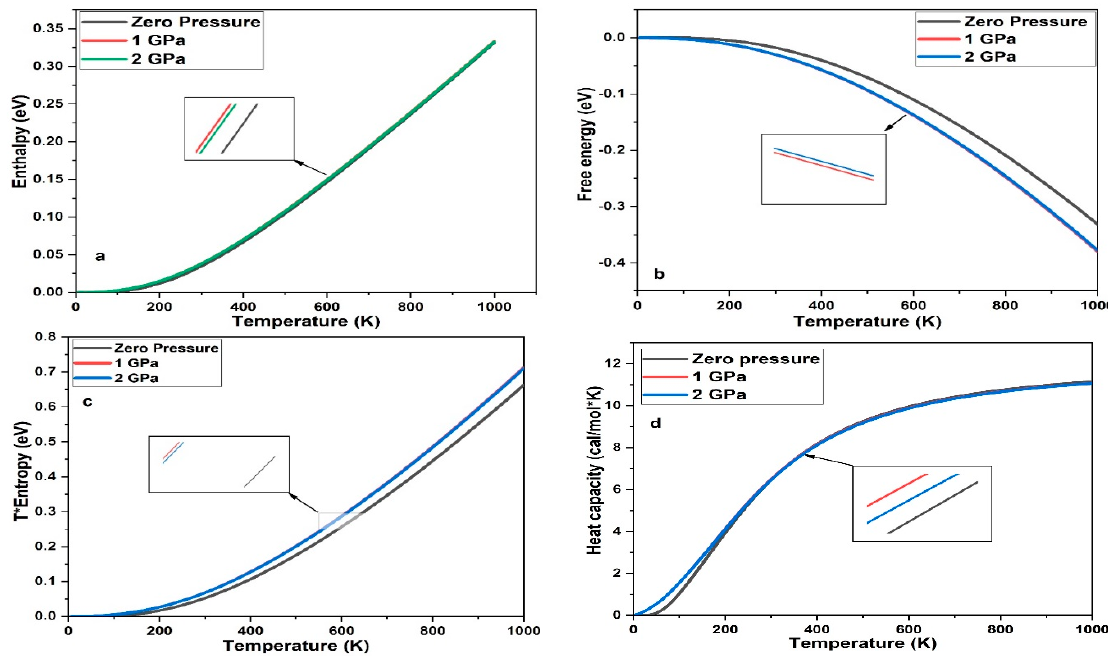
Figure 13. Enthalpy ( a ), free energy ( b ), entropy ( c ) and heat capacity ( d ) of 3C-SiC at different pres- sure.